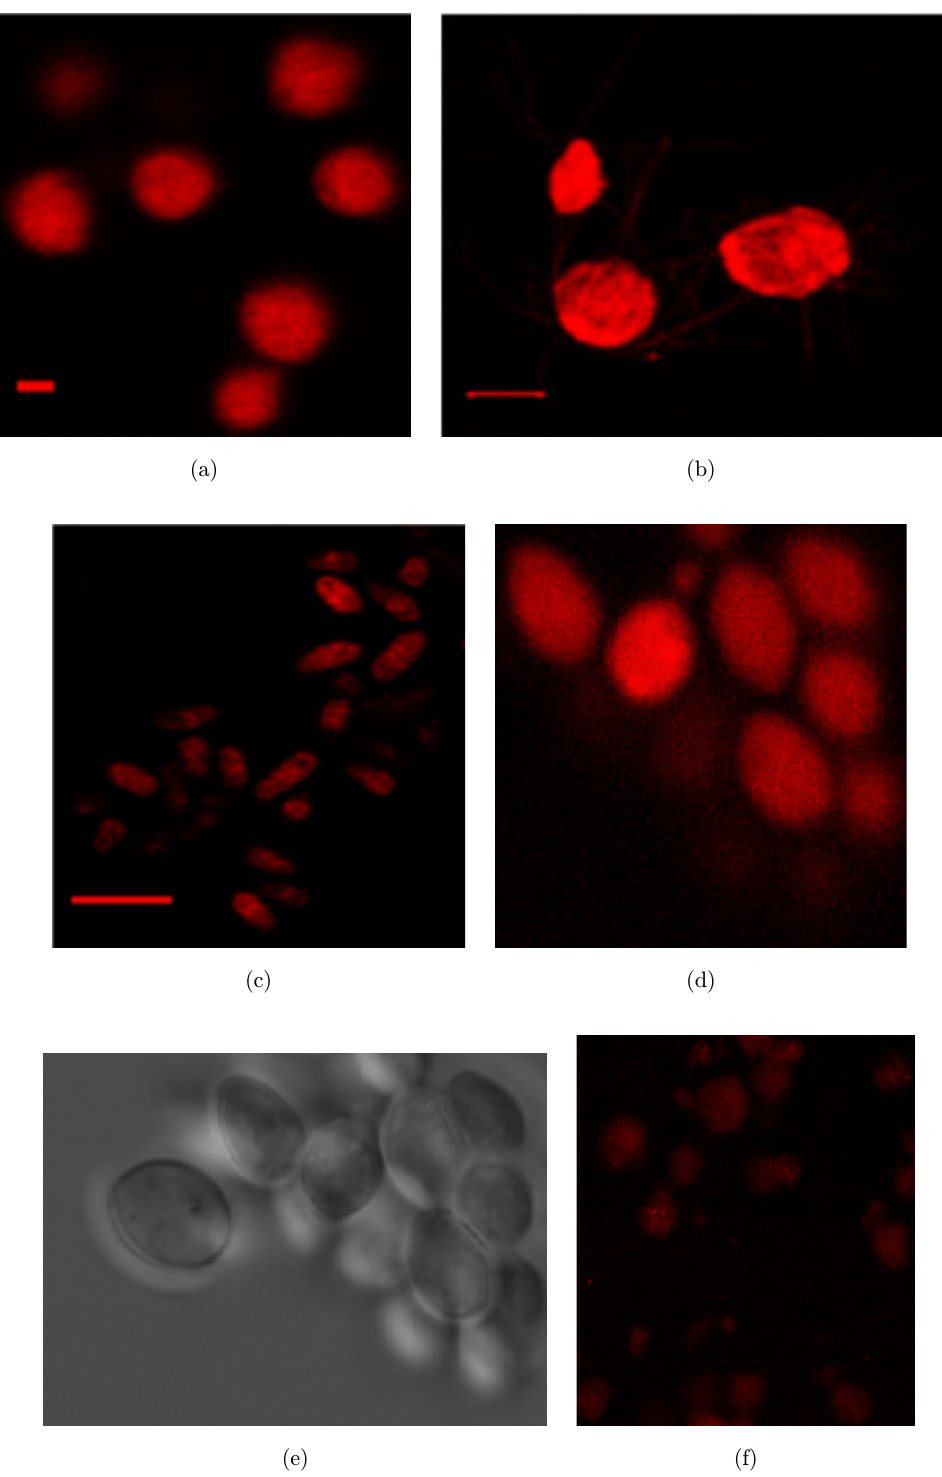
Fig. 4. Two-photon excitation scanning laser microscope images of Ru coordinate complex electroporated into: (a) human ade- nocarcinoma (MCF-7) cells, (b) the °agellated protist, Spironucleus vortens , (c) the ¯ssion yeast, Schizosaccharomyces pombe , (d) a confocal image of Saccharomyces cerevisiae , (f) rat neonatal cardiomyocytes using two-photon excitation. A Nomarski Di®erential Interference Contrast image of the yeast (e) is also shown. Untreated control cells and organisms (not exposed to or electroporated with nanoparticles) showed no red auto°uorescence. Scale bars ¼ 10 (cid:1) m. Panels (a – c) reproduced from Williams et al. 48 with